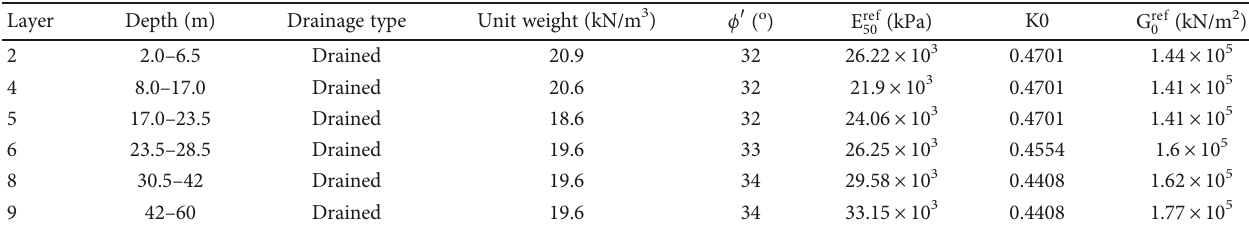
Table 2: Input parameters of soils and structures.